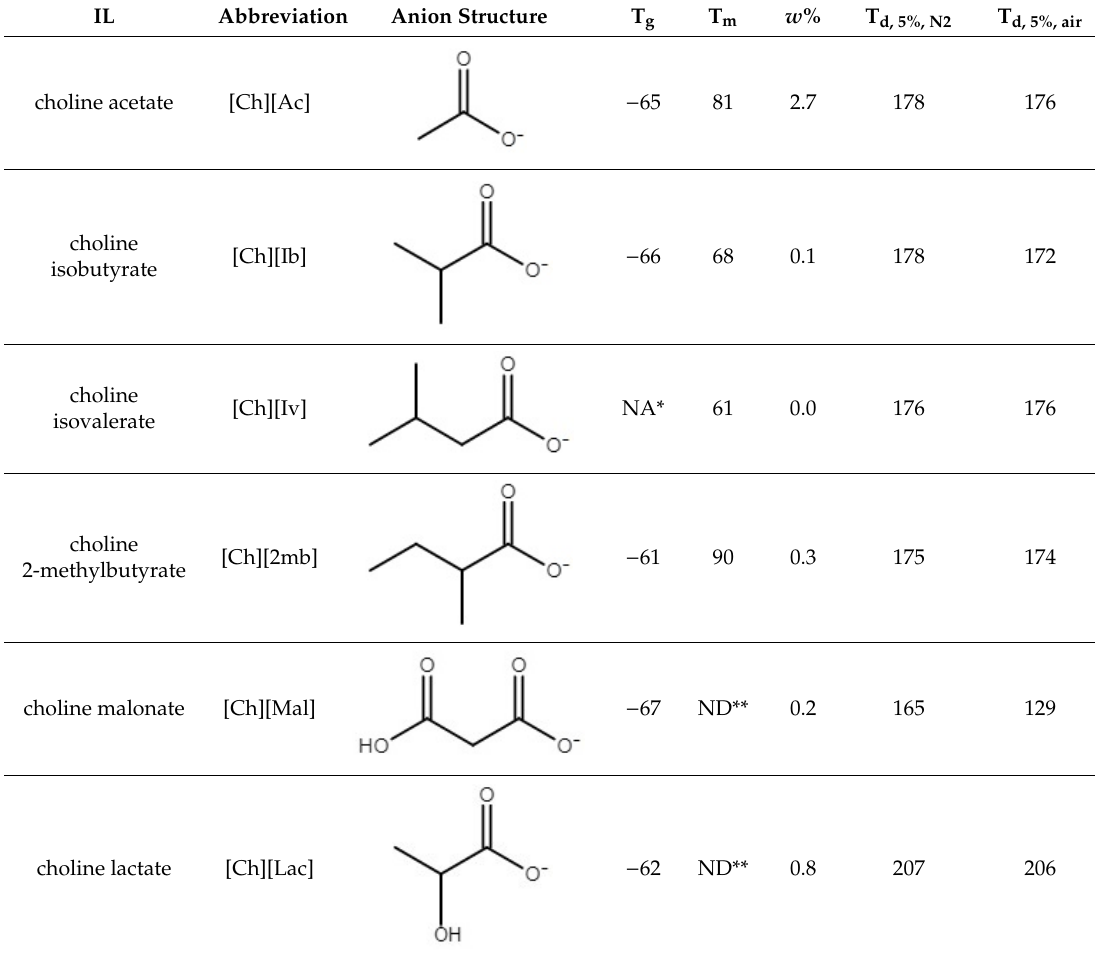
Table 1. Key properties of tested ionic liquids (ILs).